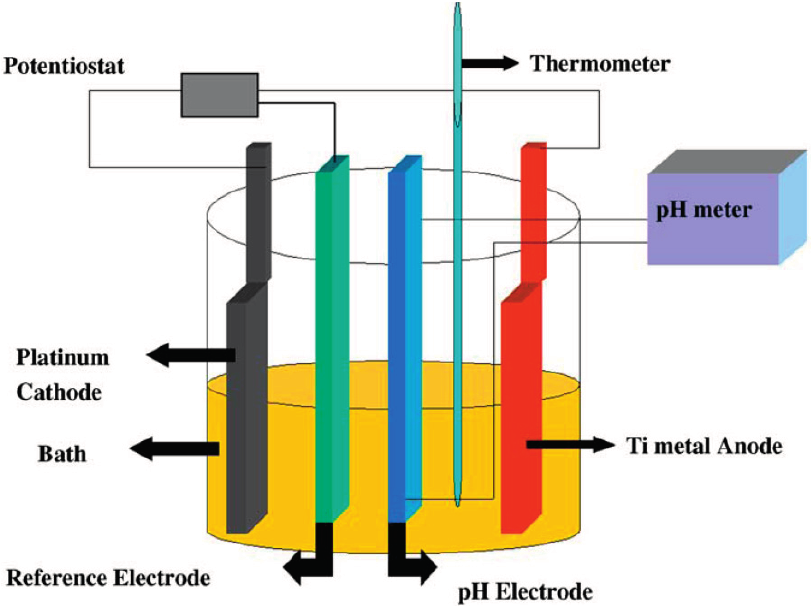
Figure 2. Scheme of an electrochemical cell enabling the formation of TNT on a Ti anode. Reproduced with permission from reference